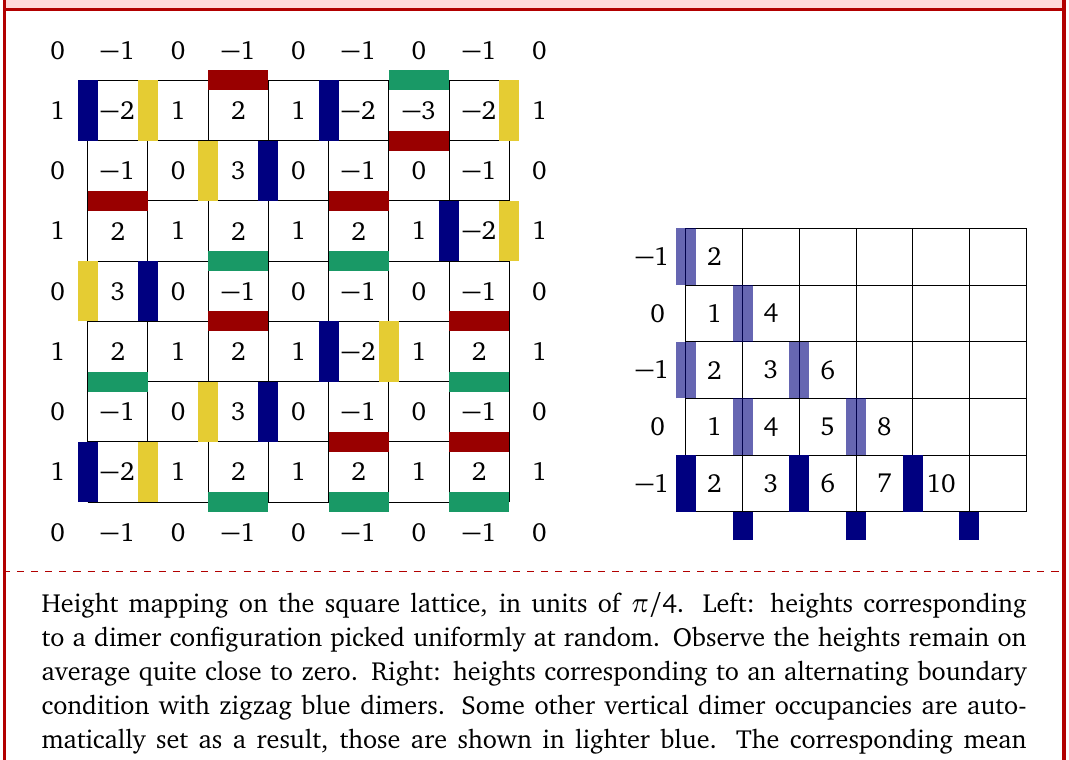
Figure 6: The height mapping for dimers on the square